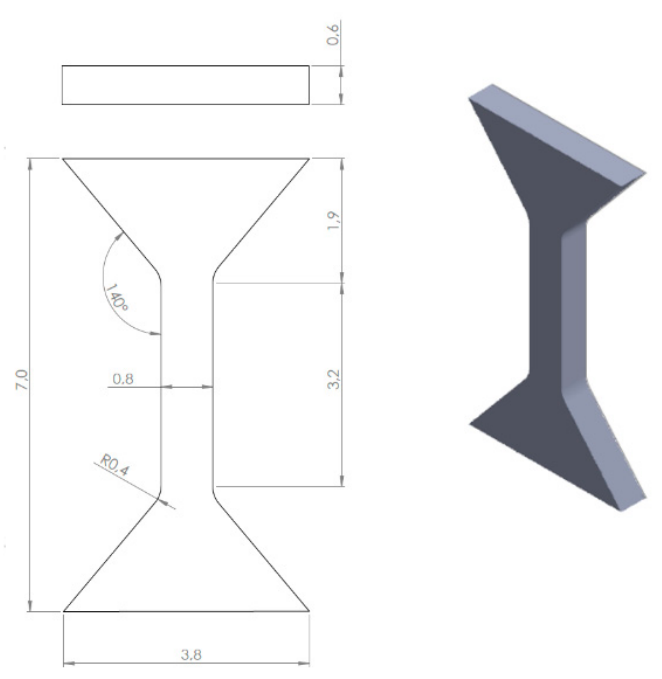
Figure 2. The scheme of mini-specimen for tensile test.